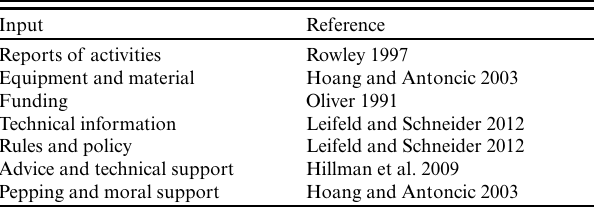
Table 1 . Seven types of input between actors (Becker 2018)